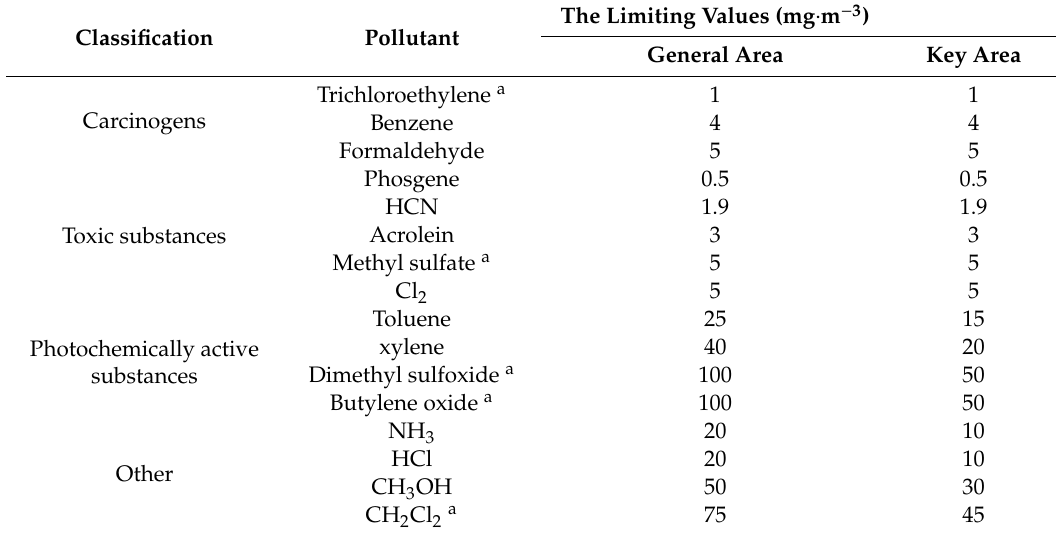
Table 2. The limiting value of specific pollutants in workshops and installations